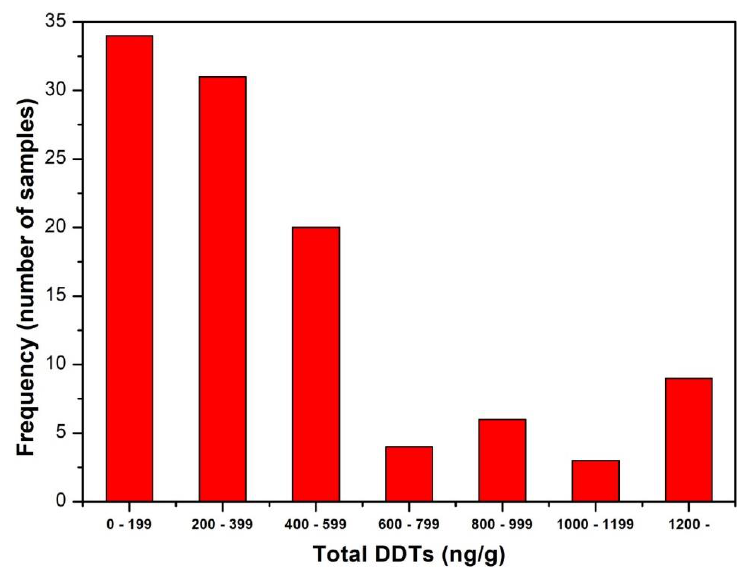
Figure 5. Frequency distribution of the concentrations of total DDTs in human fat tissue.